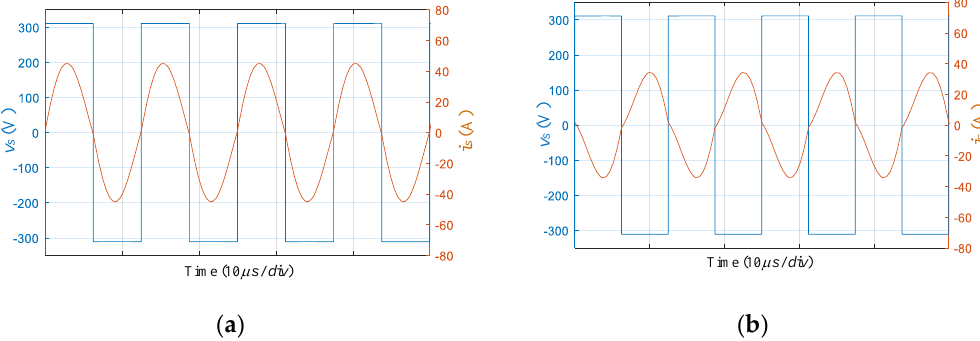
Figure 11. v s and i s in ( a ) the forward direction and ( b ) the reverse direction.